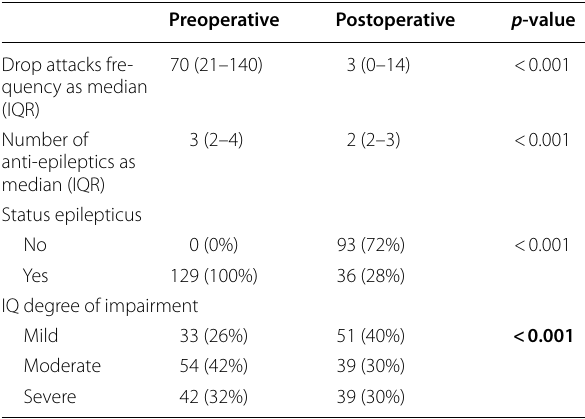
Table 2 Comparison of the main outcomes before and after surgery